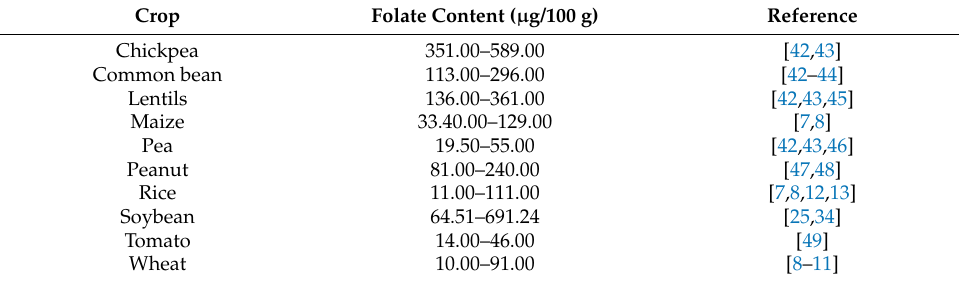
Table 2. The folate content of various